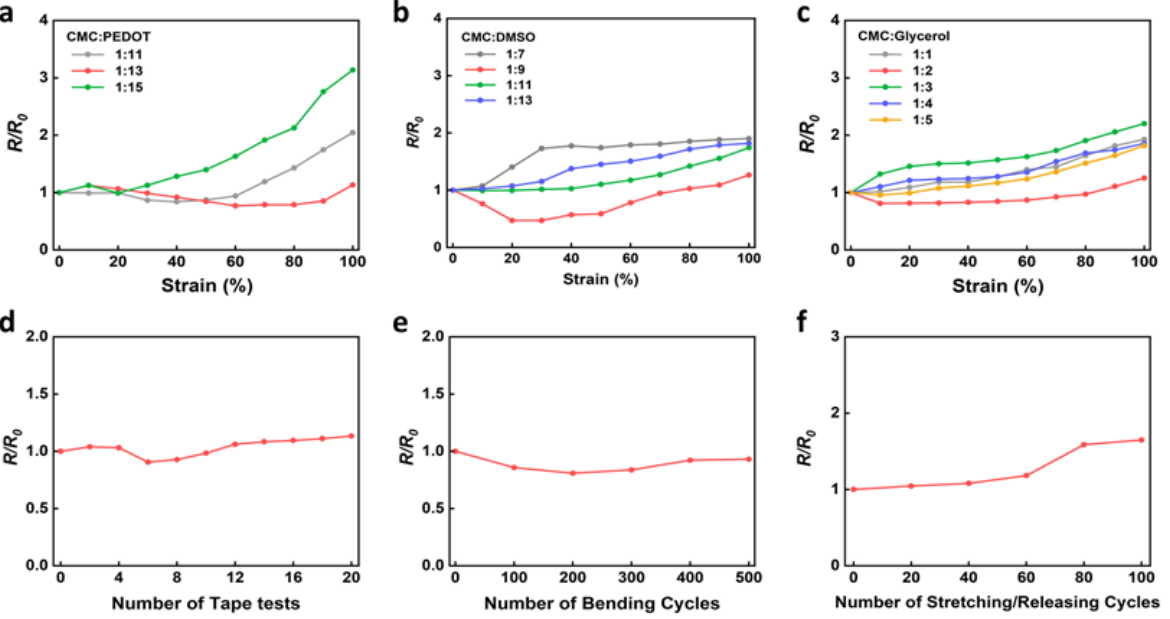
Figure 2. Relative resistance of CMC-PEDOT:PSS films as a function of ratios of CMC to ( a ) PE- DOT:PSS, ( b ) DMSO, and ( c ) glycerol. Relative resistance of the optimized CMC-PEDOT:PSS com- posite film (CMC:PEDOT:PSS = 1:13, CMC:DMSO = 1:9, and CMC:glycerol = 1:2) under ( d ) tape attach/detach, ( e ) cyclic bending, and ( f ) cyclic stretching/releasing tests.